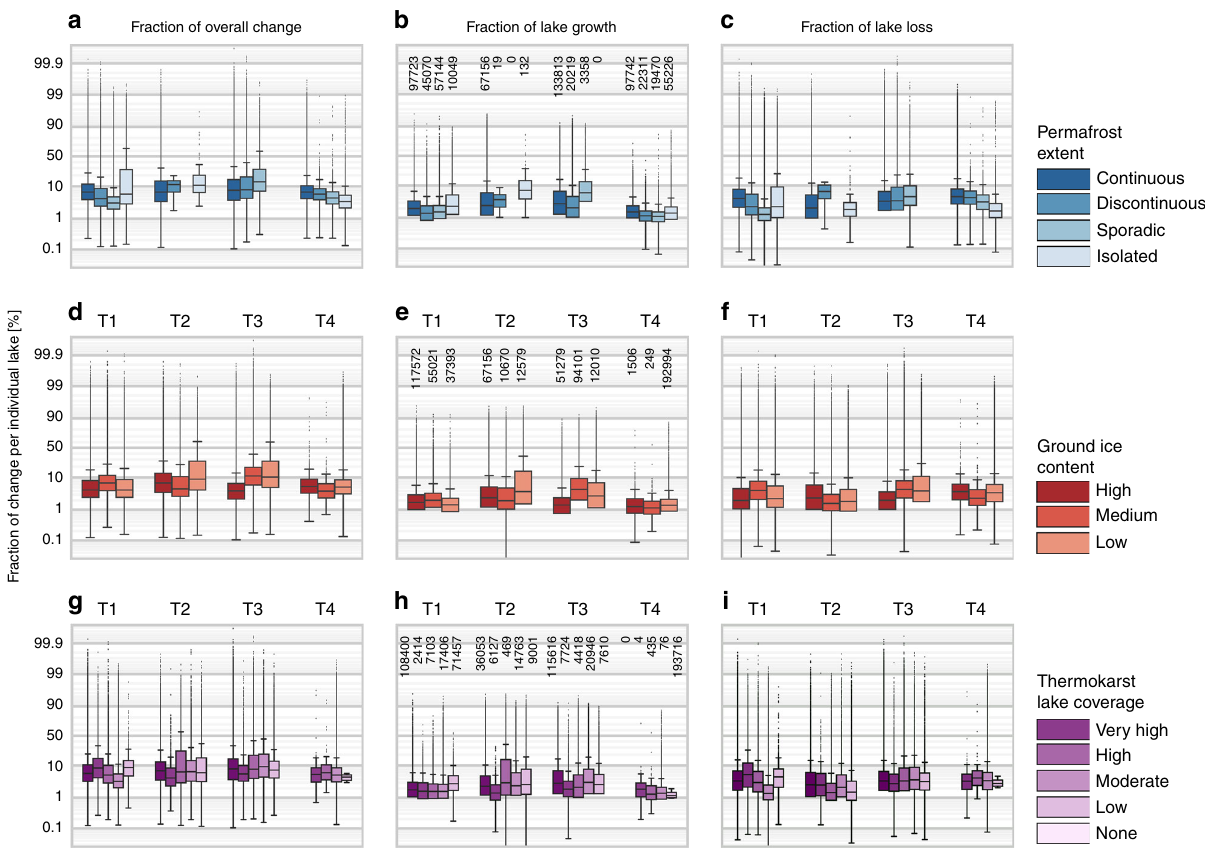
Fig. 4 Lake change and its relation to permafrost properties. Boxplots of individual lake change statistics per study area (columns) to permafrost properties (rows). a − c Overall change ( a ), gross lake growth ( b ), and gross lake loss ( c ) by permafrost extent 20 ; d − f overall change ( d ), gross lake growth ( e ), and gross lake loss ( f ) by ground-ice content 20 , g − i overall change ( g ), gross lake growth ( h ), and gross lake loss ( i ) by thermokarst lake coverage 10 . Sample sizes per group ( n lakes) indicated in middle column ( b , e , h ). Note: y -axes in logit scale. For each boxplot the centerline indicates the median, the box indicates the interquartile range (IQR), and the whiskers indicate 1.5 times the IQR past the low and high quartiles (Tukey boxplot)